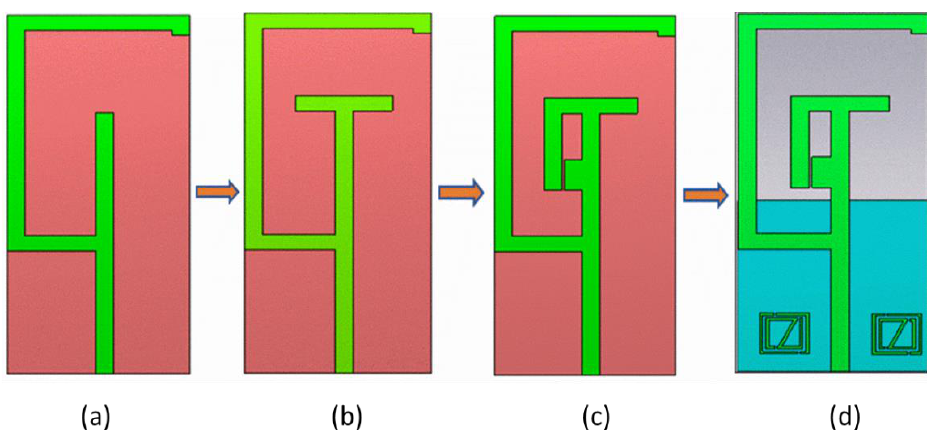
Figure 2. Antenna Iterations, ( a ) iteration 1, ( b ) iteration 2, ( c ) iteration 3, ( d ) iteration 4.